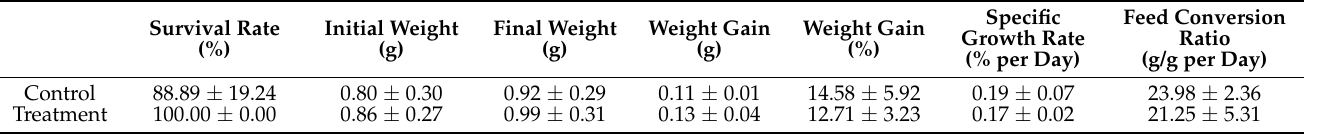
Table 3. Mean values ± S.D. of survival rate, initial and final weight, weight gain, specific growth rate, and feed conversion ratio of control and treatment